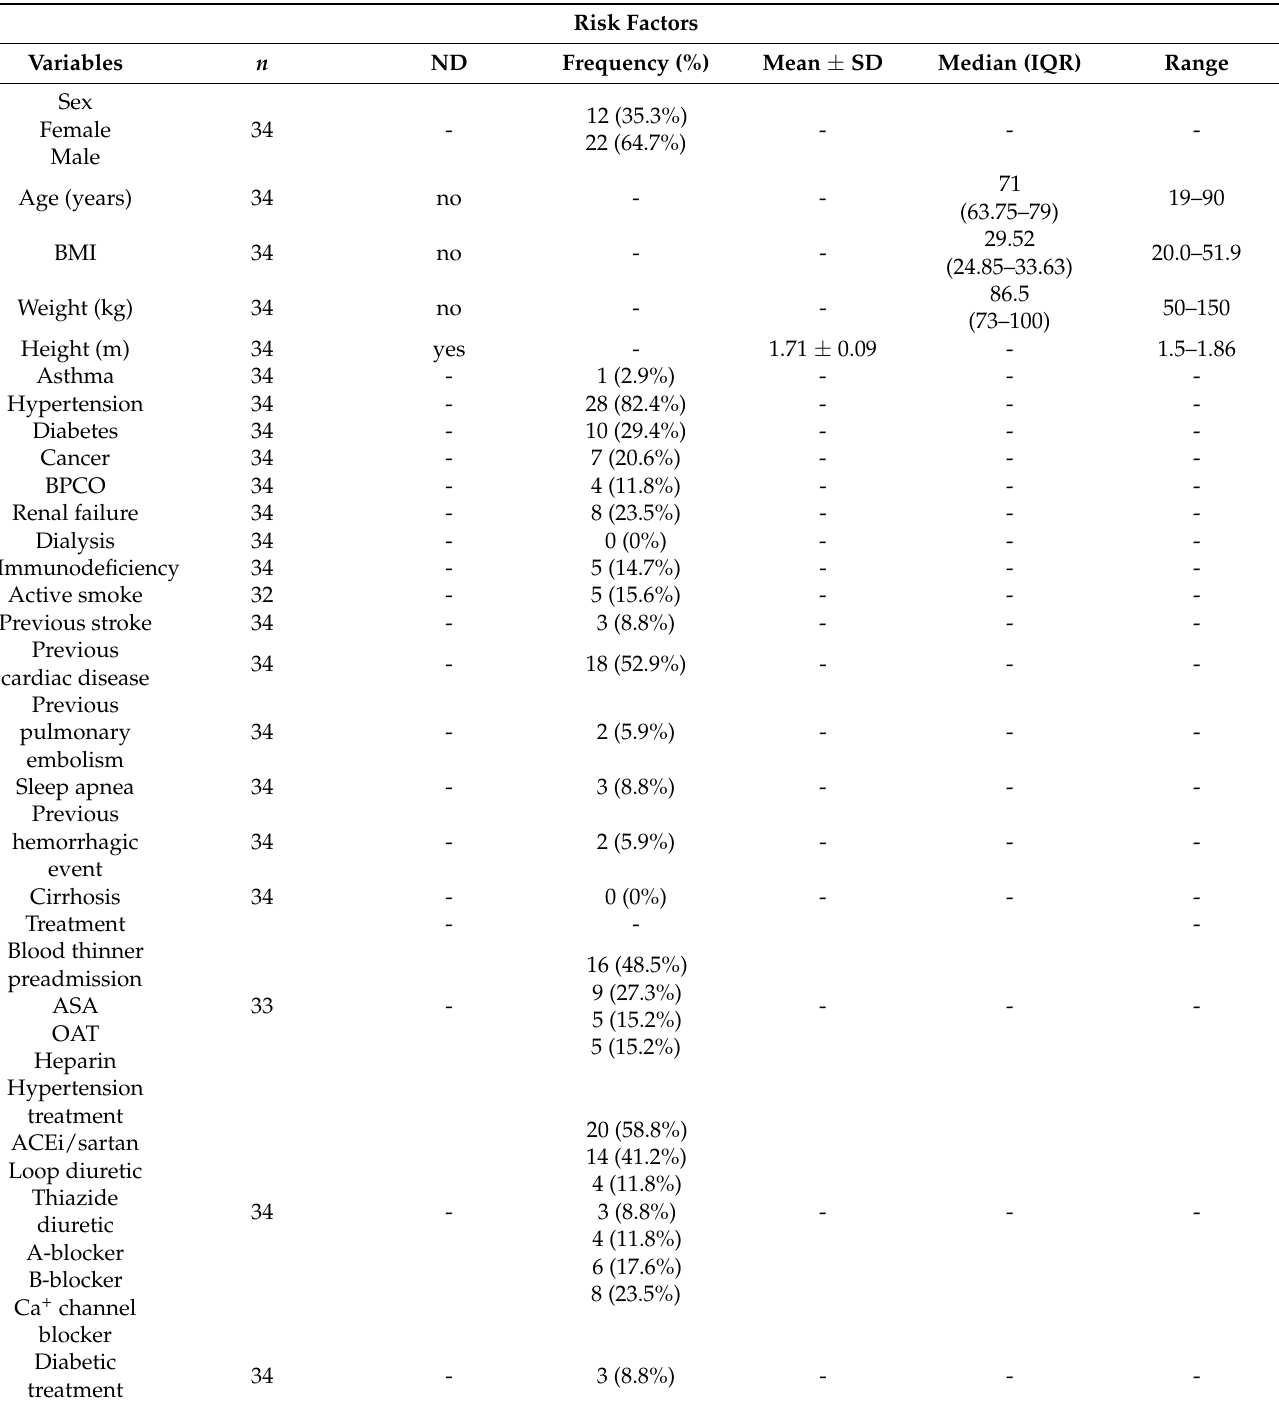
Table 1. Risk factors and descriptive